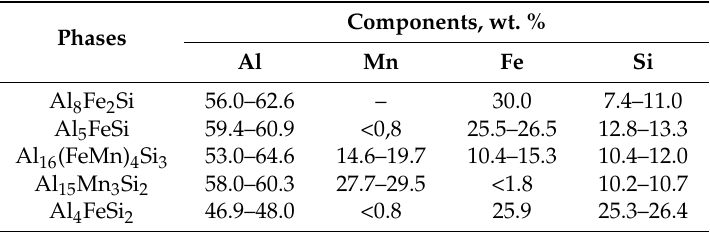
Table 2. Published data on the expected phases in the Al corner of the Al–Si–Fe–Mn system, data from